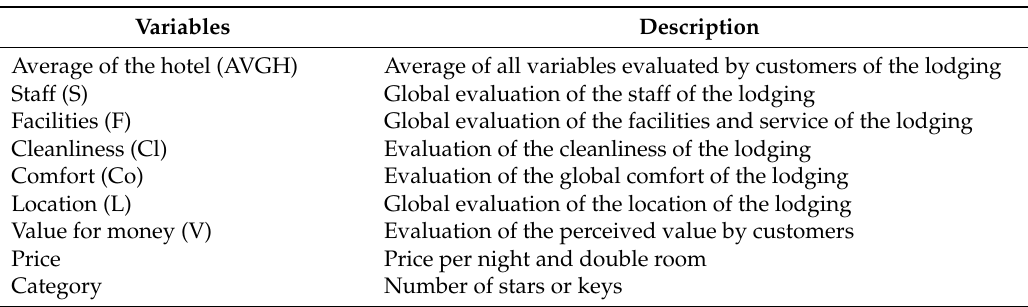
Table 1. Description of the